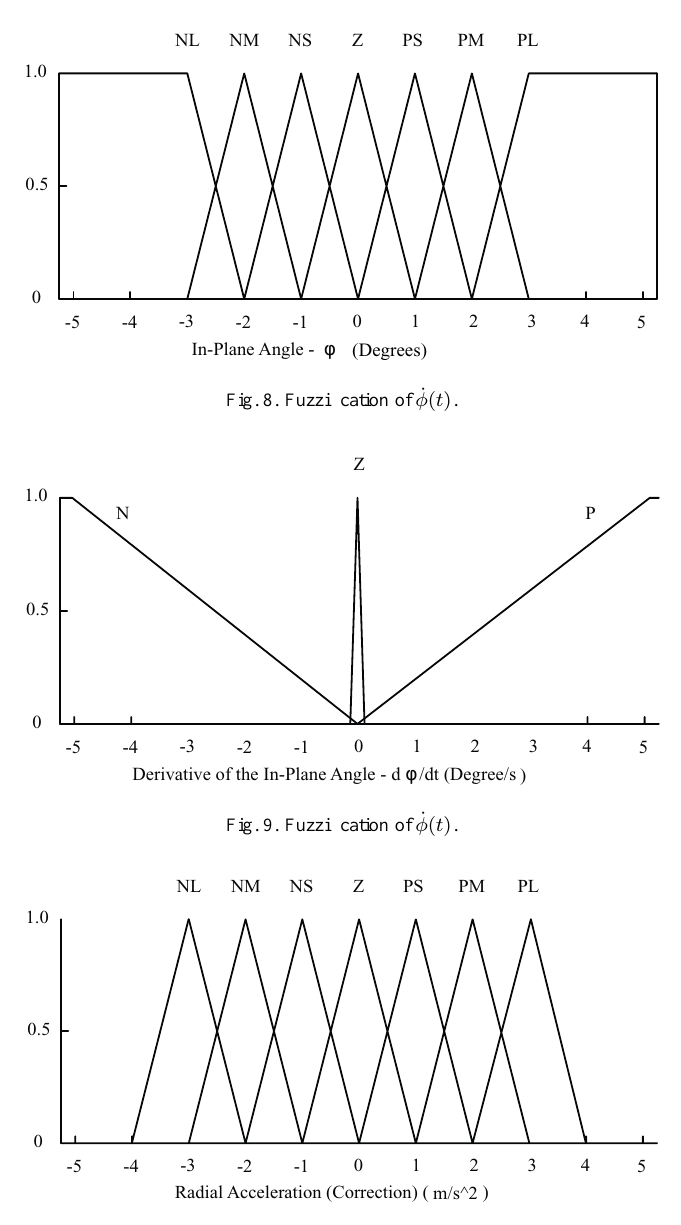
Fig. 10. Defuzzification of ¨ r Correction